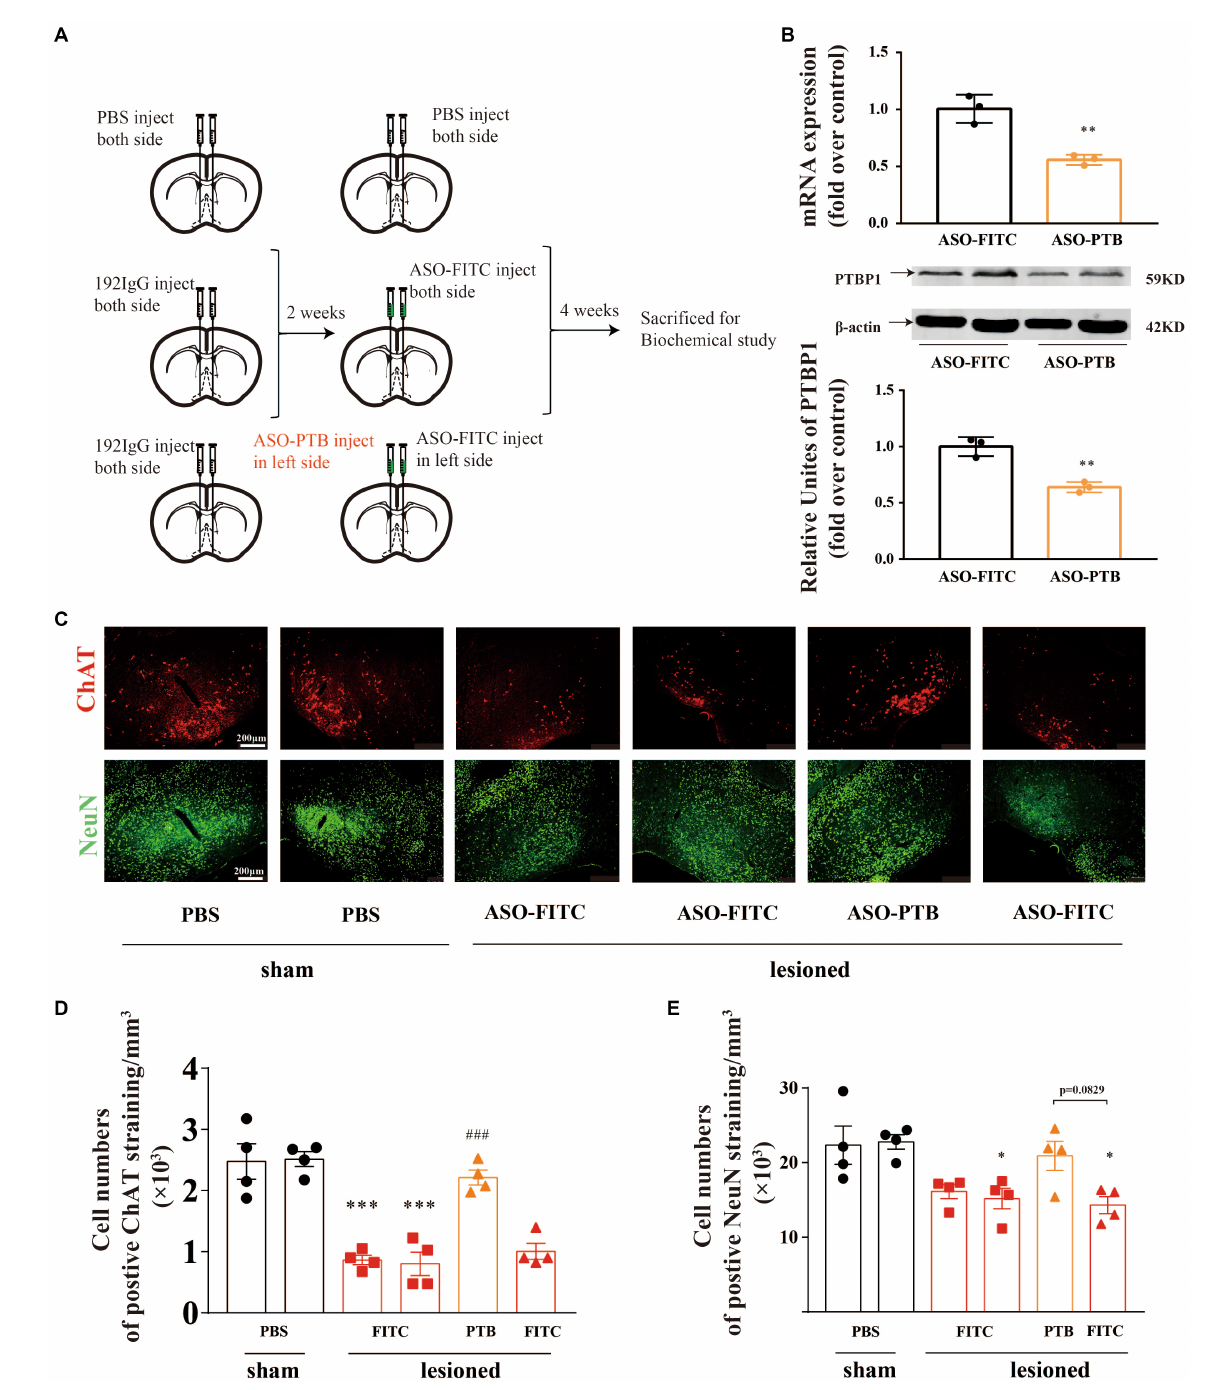
FIGURE 4 Conversion of astrocytes to neurons by ASO-PTB in HDB-cholinergic lesioned mice. (A) Experimental schedules. (B) The mRNA (two-tailed unpaired t -test, t = 5.268, df = 4, ** p = 0.0062, n = 3) and protein (two-tailed unpaired t -test, t = 6.472, df = 4, ** p = 0.0029, n = 3) contents of PTB in mice were significantly decreased by injecting ASO-PTB, compared to the ASO-FITC group. The arrow refers to the target band. (C) HDB brain area, co-stained with ChAT (red) and NeuN (green). Scale bar represents 200 μ m. (D) Significant differences in density of ChAT-positive cell between the sham and 192 IgG-saporin groups by quantitative analysis. ASO-PTB injection significantly increased the number of cholinergic neurons (one-way ANOVA, Tukey’s multiple comparisons test, F (5,18) = 24.16, *** p < 0.001, from left to right, compared to the sham site, ### p < 0.001, compared to the ASO-FITC, n = 4). (E) Significant increase in density of NeuN-positive cell between the sham and 192 IgG-saporin groups. ASOs injection significantly increased the number of neurons (one-way ANOVA, Tukey’s multiple comparisons test, F (5,18) = 5.703, * p = 0.0351, * p = 0.0234, from left to right, compared to the sham left site, p = 0.0829 compared to the lesioned right site, n = 4). *Compared to the sham group, # compared to the ASO-FITC group. Data are expressed as mean ±